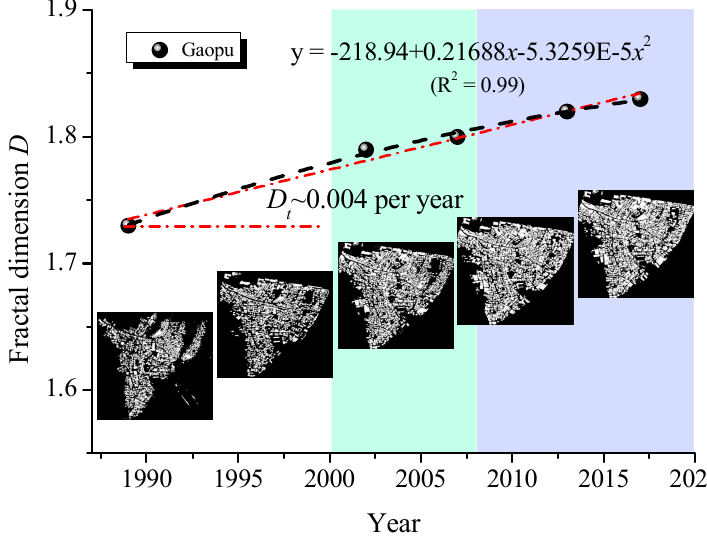
Figure 5. Time evolution of the fractal dimension of Gaopu settlement.